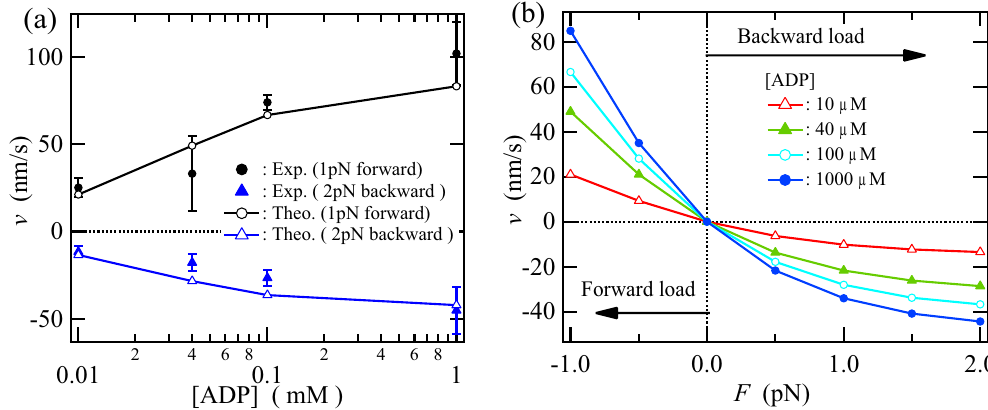
Figure 2. ATP-free force-assisted passive bidirectional movement of kinesin in the presence of ADP. ( a ) Comparison between the experimental data and the results provided by the three-state model (hereafter referred to as the theoretical results) for the ADP-concentration dependence of the motor velocity at 1 pN forward force and 2 pN backward force. The experimental data are taken from the literature 45 . ( b ) Theoretical results for the force dependence of the motor velocity at different ADP